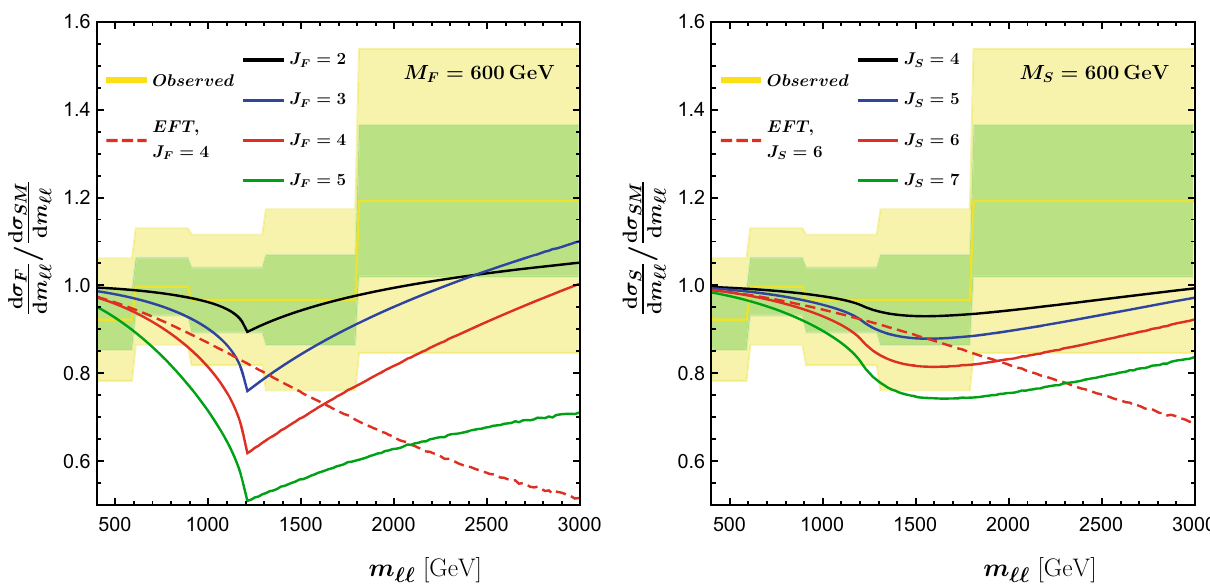
Fig. 2 Ratio of the modified Drell–Yan invariant mass distribution to theSMexpectationattheLHC.Foramultipletmassof M R = 600GeV, theleft(right)panelconsiderstheeffectoffourdifferentisospinchoices